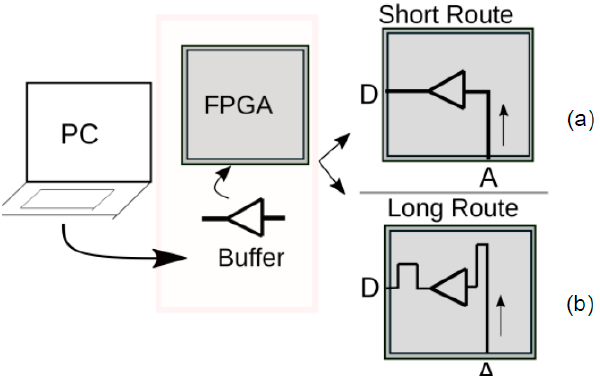
Figure 6. An illustration of programming FPGA with a buffer circuit and implementation of a route to the input-output port/pin (A and D in this Figure) of FPGA. ( a ) Implementation of short route between ports A and D. ( b ) Implementation of long route between port A and D.